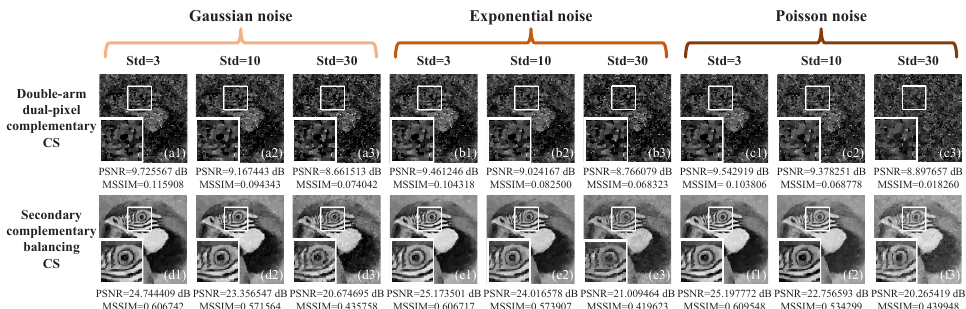
Figure 4. Reconstructed results of 128 × 128 pixels with 25% sampling rate under additive noise of three kinds of distributions. ( a1 – f3 ) are the results of the double-arm dual-pixel complementary CS method and secondary complementary balancing CS method under the Gaussian, exponen- tially and Poisson distributed noise, respectively. Here, Std denotes the standard deviation of the noise